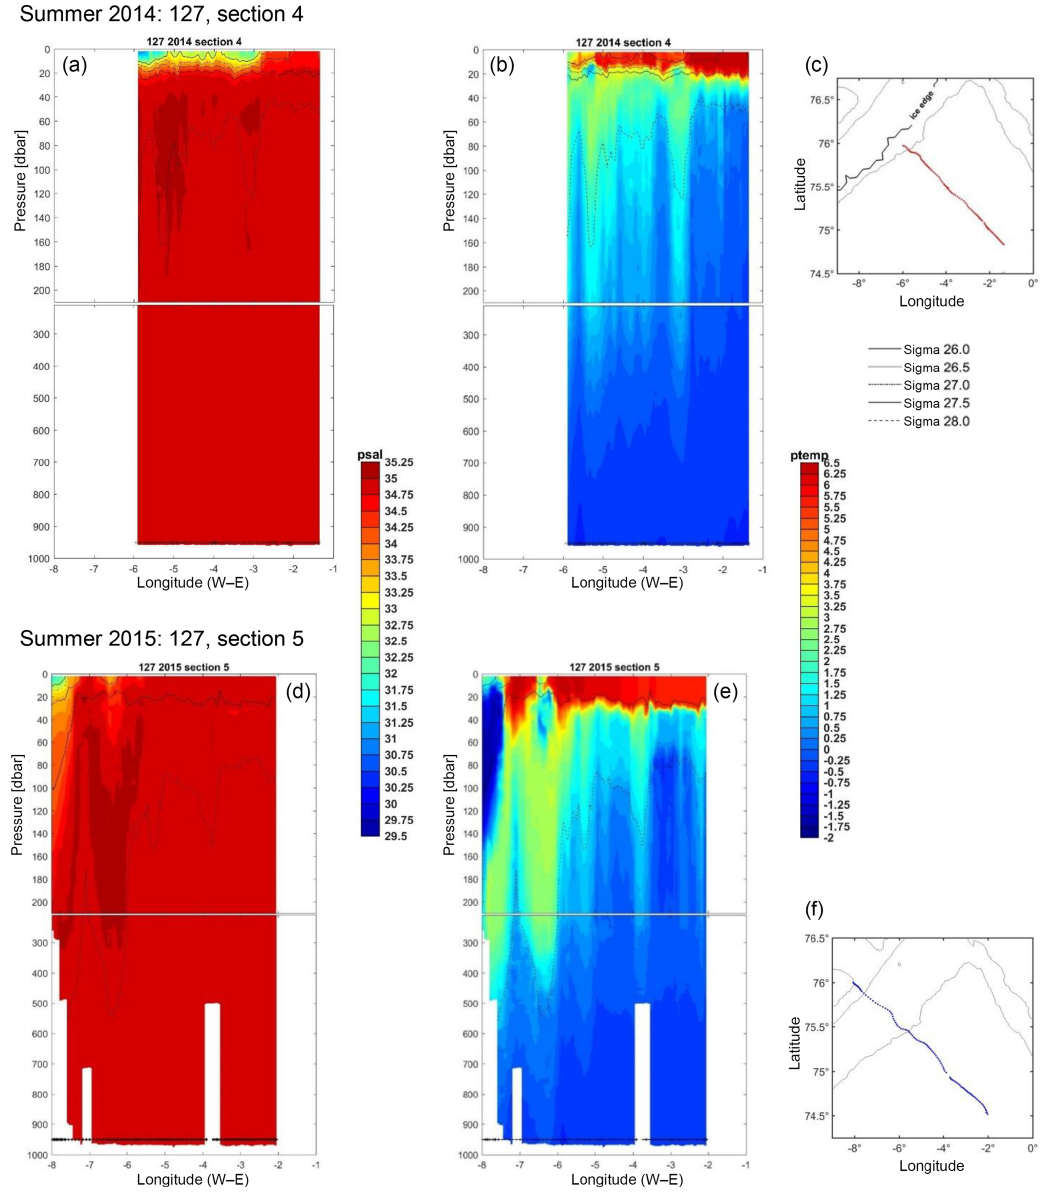
Figure 7. Deep sections (0 to 1000dbar), one for each summer as an example. (a, b) Salinity. (b, e) Potential temperature. (a, b, c) 2014; (d, e, f) 2015. In (c, f) , map extracts show the position of the sections. For 2014, the ice edge at the arrival time of the glider at the edge is also included in the map. During 2015, no ice was observed within the map extract. Sigma-contours for 26.0, 26.5, 27.0 and 27.5kgm − 3 are superimposed. The stars at the bottom of each section mark the position of the profiles before the gridding of the data in the horizontal took place. Section 4 from glider 127, 2014, from northwest (a) to southeast (b) ; original dives: 168 to 280, profiles 260 to 353 of the final data set, time span 2 to 8 August, ice edge information from 5 August. Section 5 from glider 127, 2015, from northwest (d) to southeast (e) ; original dives: 144 to 197, profiles 231 to 336 of the final data set, time span 11 to 22